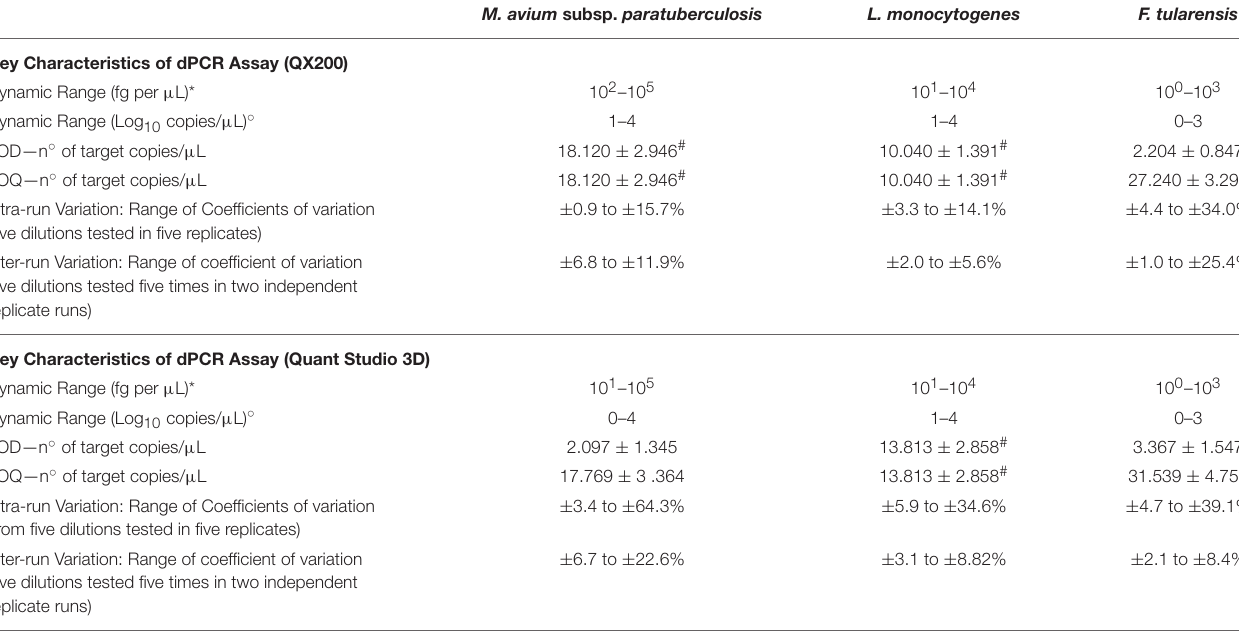
TABLE 1 | Performances of dPCR systems used in the study for detection and quantification of M. avium subsp. paratuberculosis , L. monocytogenes, and F. tularensis